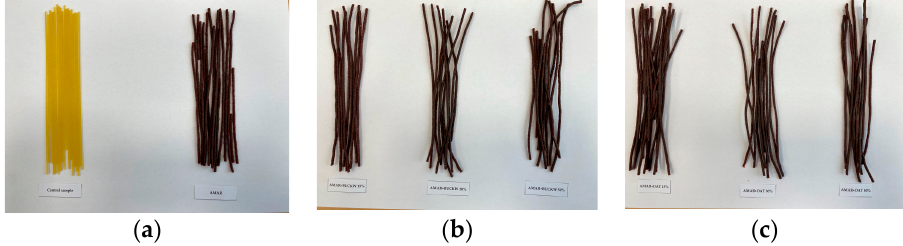
Figure 1. Experimental pasta: ( a ) control sample and AMAR; ( b ) amaranth pasta blends with buck- wheat flour—AMAR+BUCKW 15%, AMAR+BUCKW 30%, and AMAR+BUCKW 50%; ( c ) amaranth pasta blends with oat flour—AMAR+OAT 15%, AMAR+OAT 30%, and AMAR+OAT 50%.